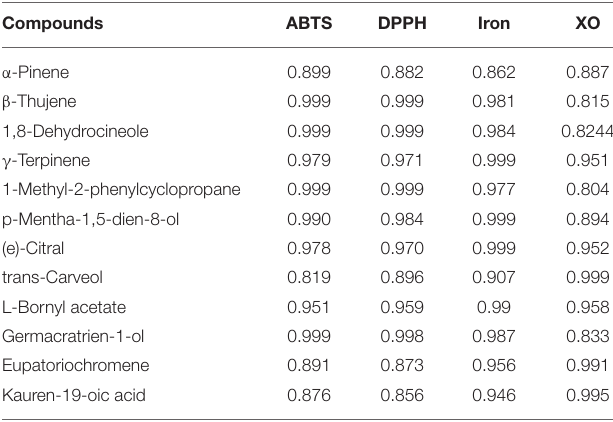
TABLE 6 | The Pearson correlation coefficient (r) of the chemical compounds of SEOs with antioxidant activity and XO inhibition ability. Compounds ABTS DPPH Iron